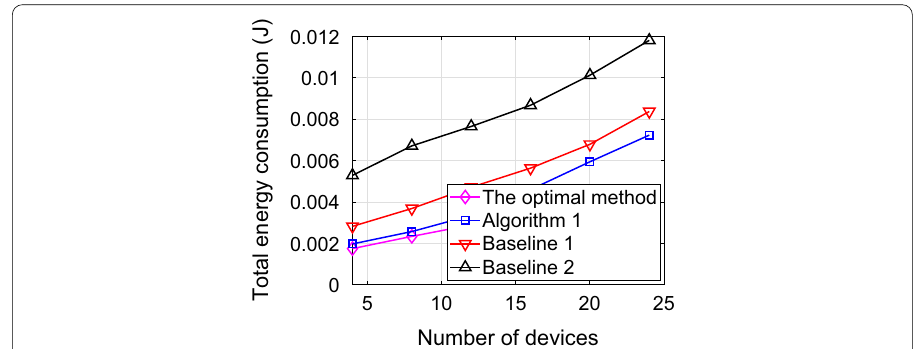
Fig. 3 The total energy consumption v.s. IoT devices number, K